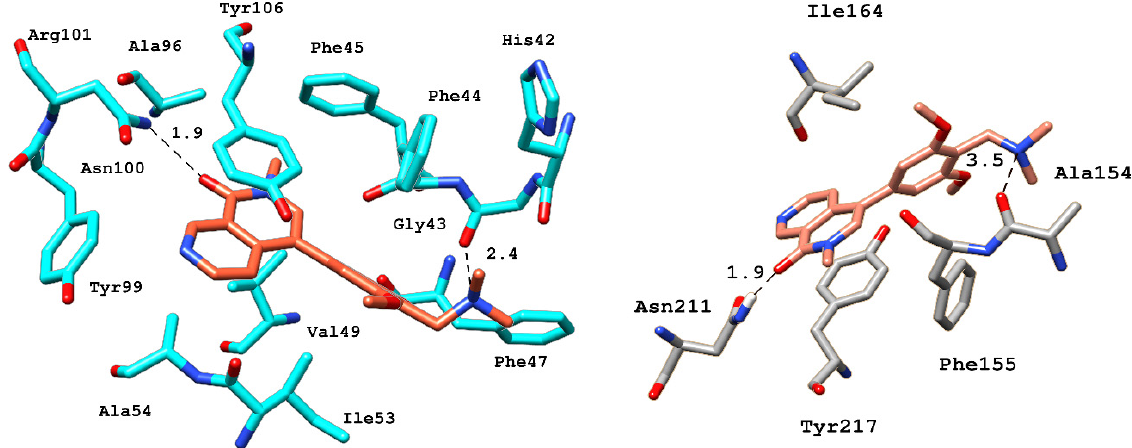
Figure 6. 3D representation of various electrostatic and hydrophobic interactions of the reference compound with BRD9 (cyan) and BRD7 (gray) binding pocket residues.